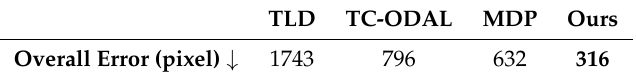
Figure 11. The frame-based trajectory modeling errors (lower is better) for four methods. The horizontal axe denotes the frame number, and the vertical axe represents the error value measured in pixels. Table 3. The overall trajectory modeling errors (lower is better) for four methods: tracking-learning- detection (TLD), tracklet confidence and online discriminative appearance learning (TC-ODAL), the Markov decision process (MDP), and ours. The error value is measured in pixels. The best value is highlighted using a bold